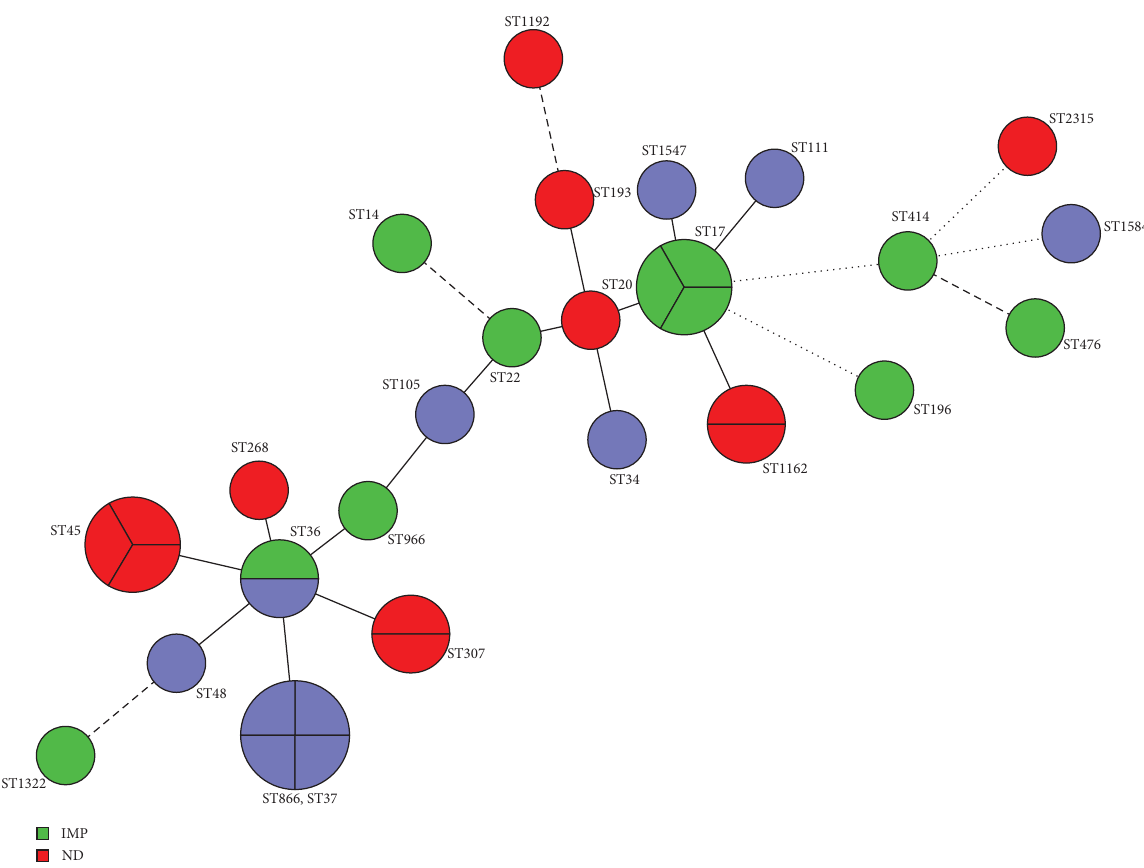
Figure 3: Minimum spanning trees of 34 CRKP isolates. Each node represents a single ST. Te size of the nodes is proportional to the number of strains within the representative ST. Te color distribution represents the distribution of carbapenemase genes among 24 diferent